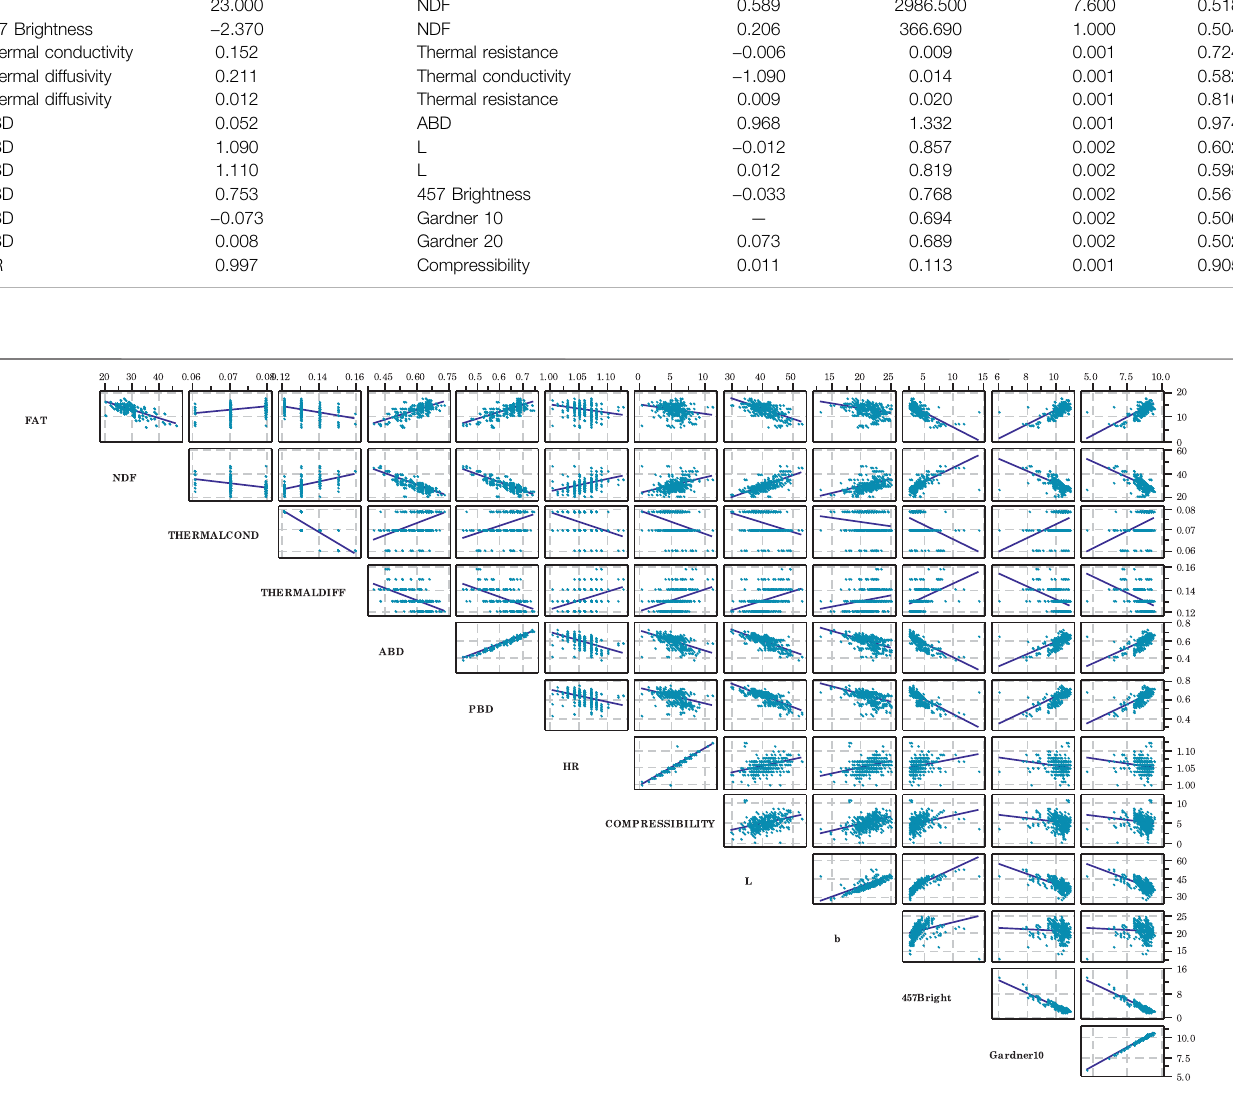
Frontiers in Bioengineering and Biotechnology |